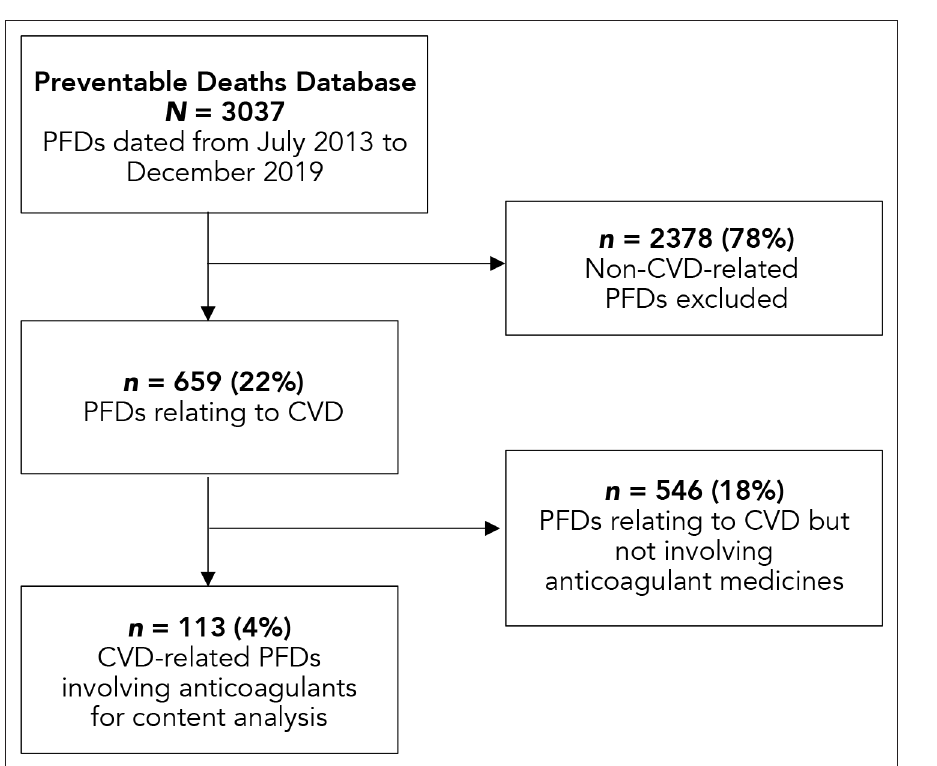
Figure 1 Flow diagram showing the numbers of Prevent Future Death reports (PFDs) included and excluded